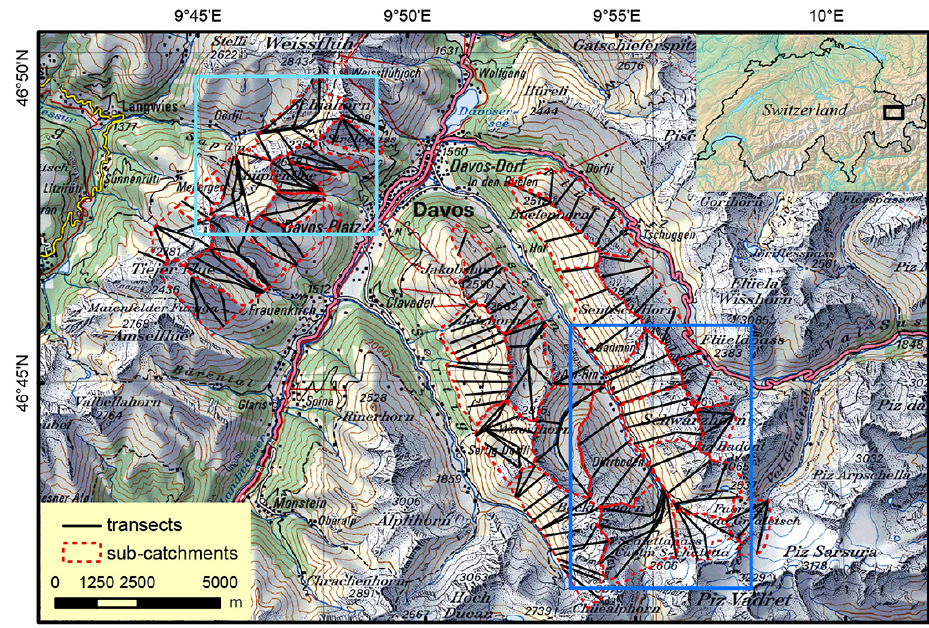
Figure 2. Overview map on the study region DIS and STRE. The upper left panel indicates the position in the east of Switzerland. Detailed views for parts of the domains are shown in Fig. 3. Maps reproduced with permission (Swisstopo,